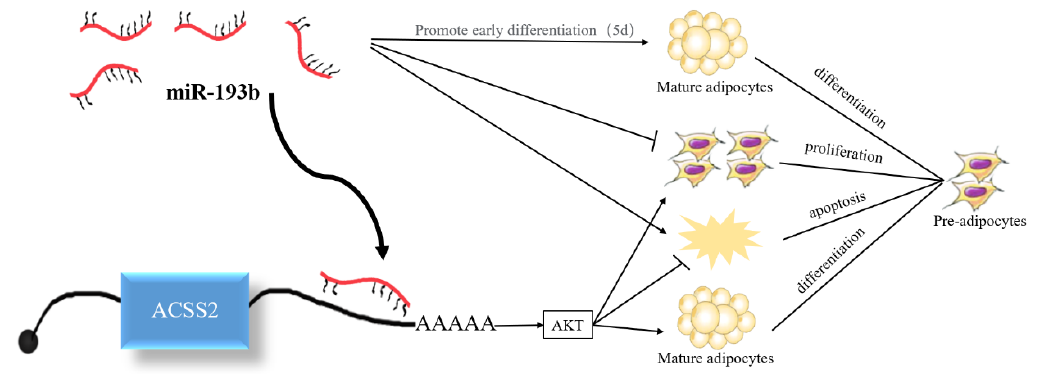
Figure 8. Proposed model of bta-miR-193b regulation on adipocyte growth and development by targeting ACSS2 .